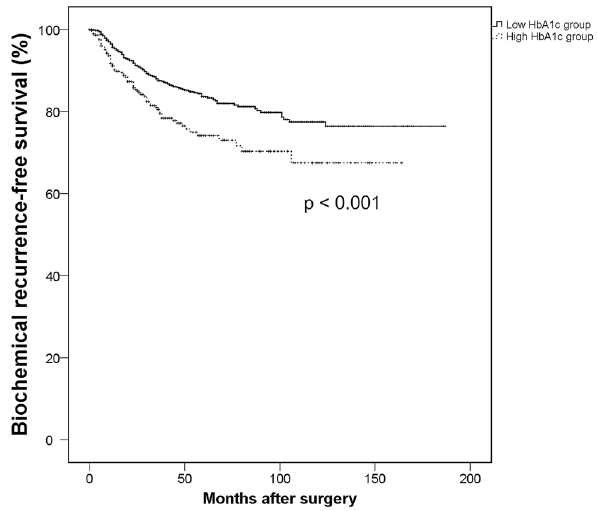
Figure 1. Kaplan–Meier analyses on biochemical recurrence-free survival according to the preoperative HbA1c.